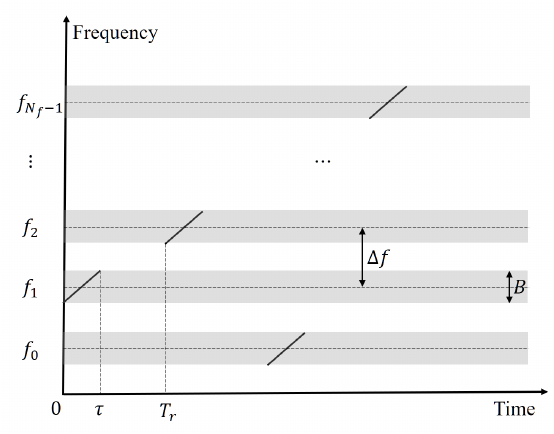
Figure 1. Simplified diagram of the transmitted